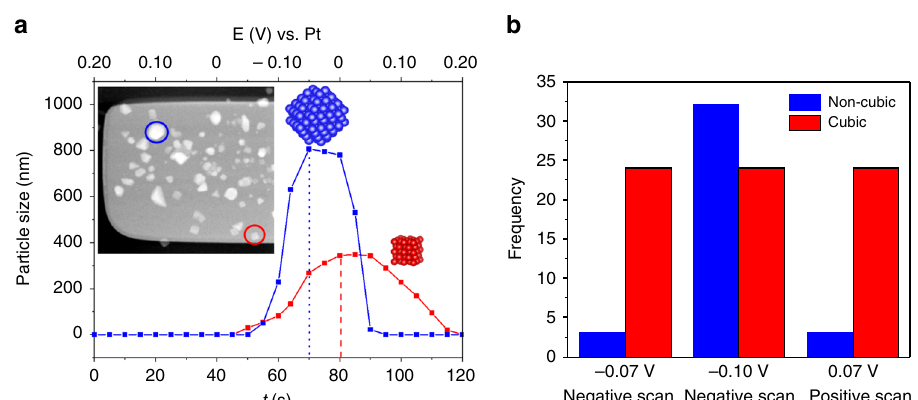
Fig. 2 Potential-induced changes in particle size and morphology. a Non-cubic (blue solid line) and cubic (red solid line) particle size evolution of the selected particles marked in the STEM image with a circle of the corresponding color as a function of time and applied potential. b Evolution of the frequency of non-cubic and cubic particles deposited on the working electrode with the applied potential.